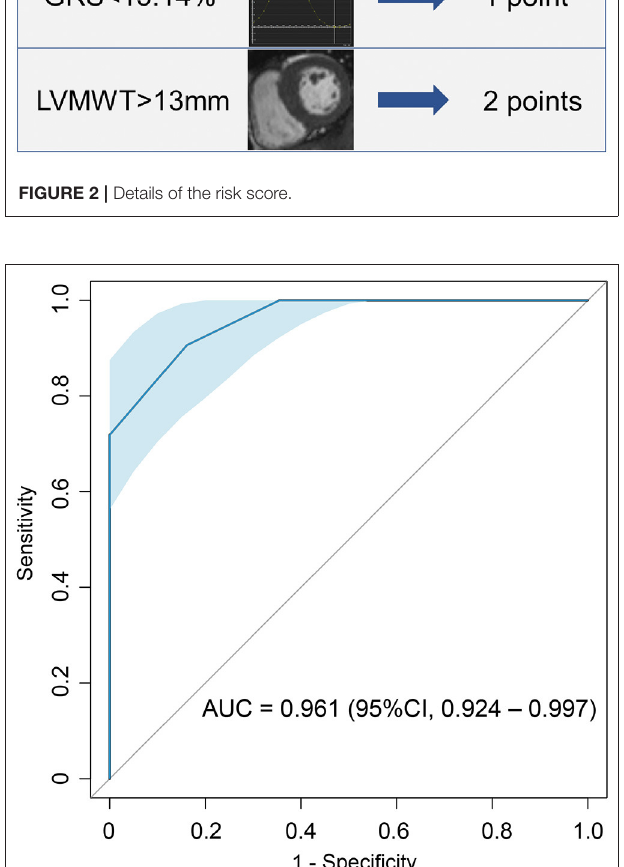
FIGURE 3 | ROC analysis of the total score recorded by the risk score in identifying AL CA patients.